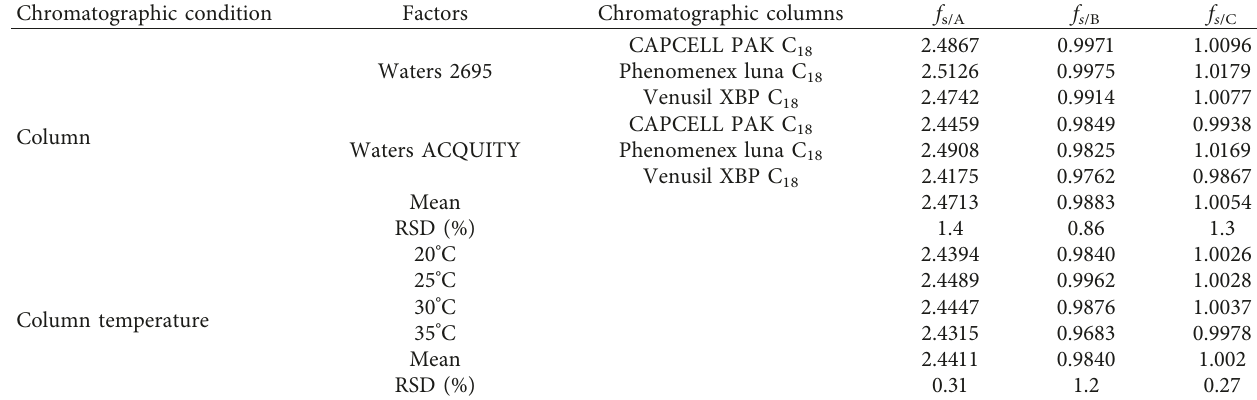
Table 5: The RCF values of three alkaloids in different conditions.